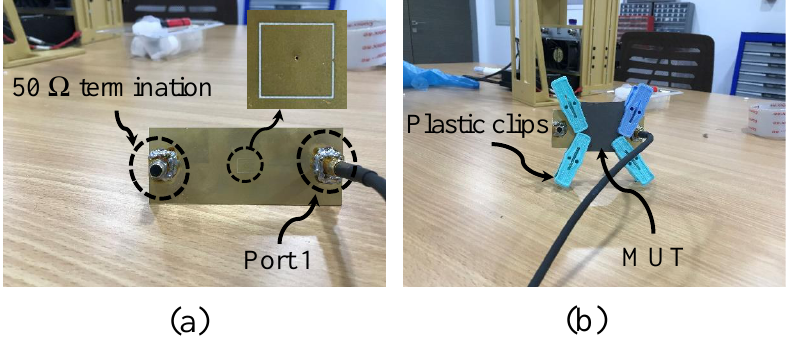
Figure 13. The experimental setup for measuring the response of the proposed sensor. ( a ) The proposed sensor terminated with a 50 Ω impedance, ( b ) where the sensor is placed in the free space.